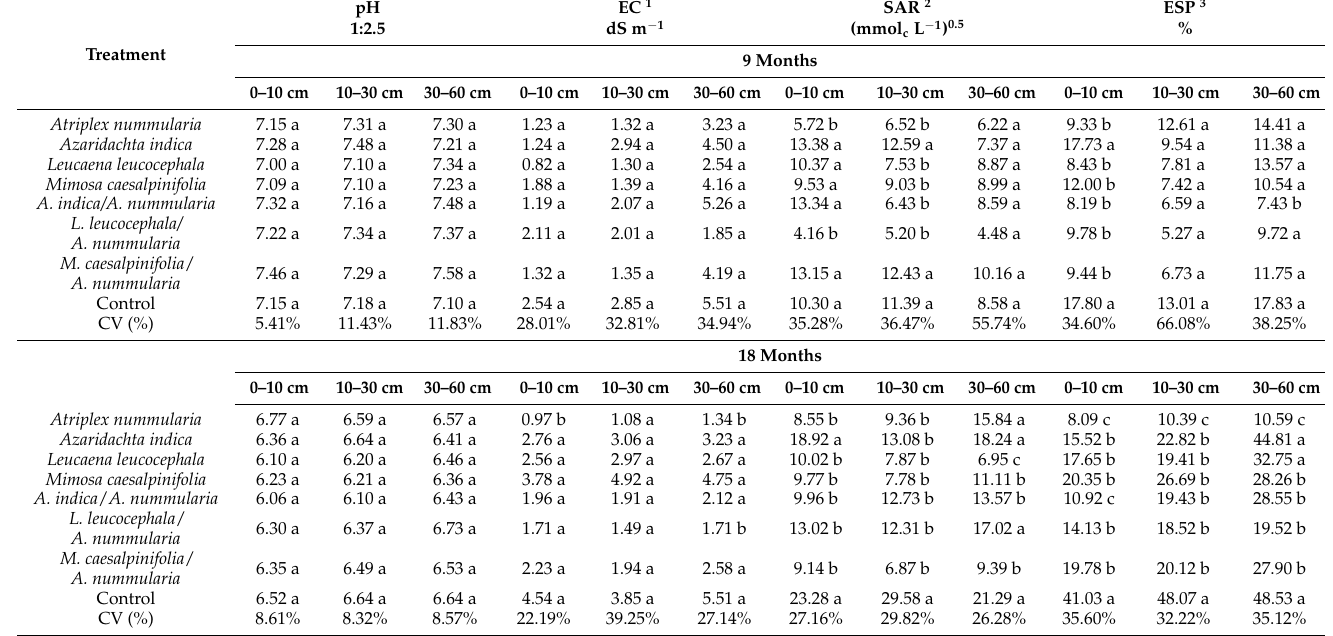
Table 4. Chemical attributes pH (hydrogen potential), EC (electrical conductivity), SAR (sodium adsorption ratio), and ESP (exchangeable sodium percentage) in the soil at 0–10, 10–30, and 30–60 cm depth as a function of treatments at 9 and 18 months (mean of four